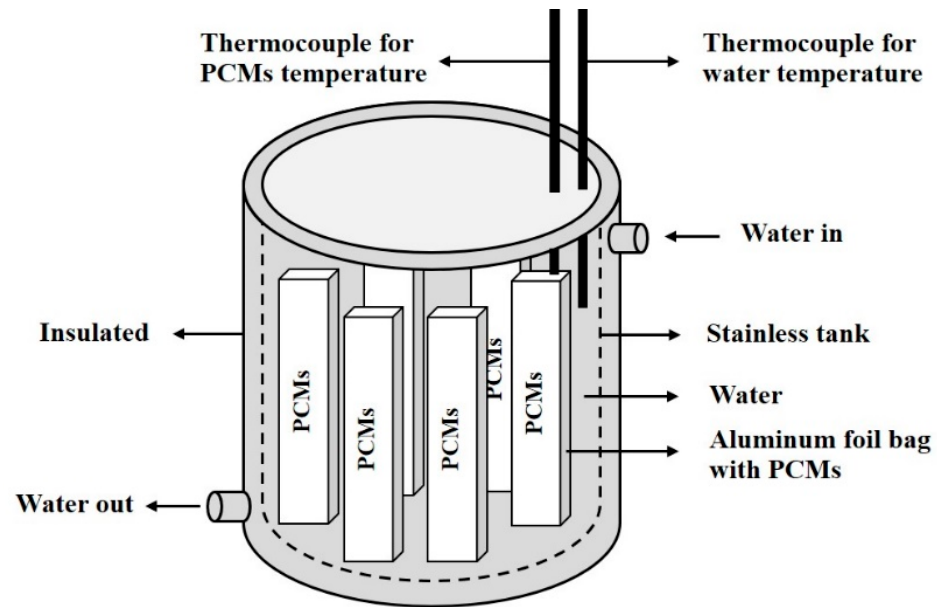
Figure 4. Thermal energy storage system.